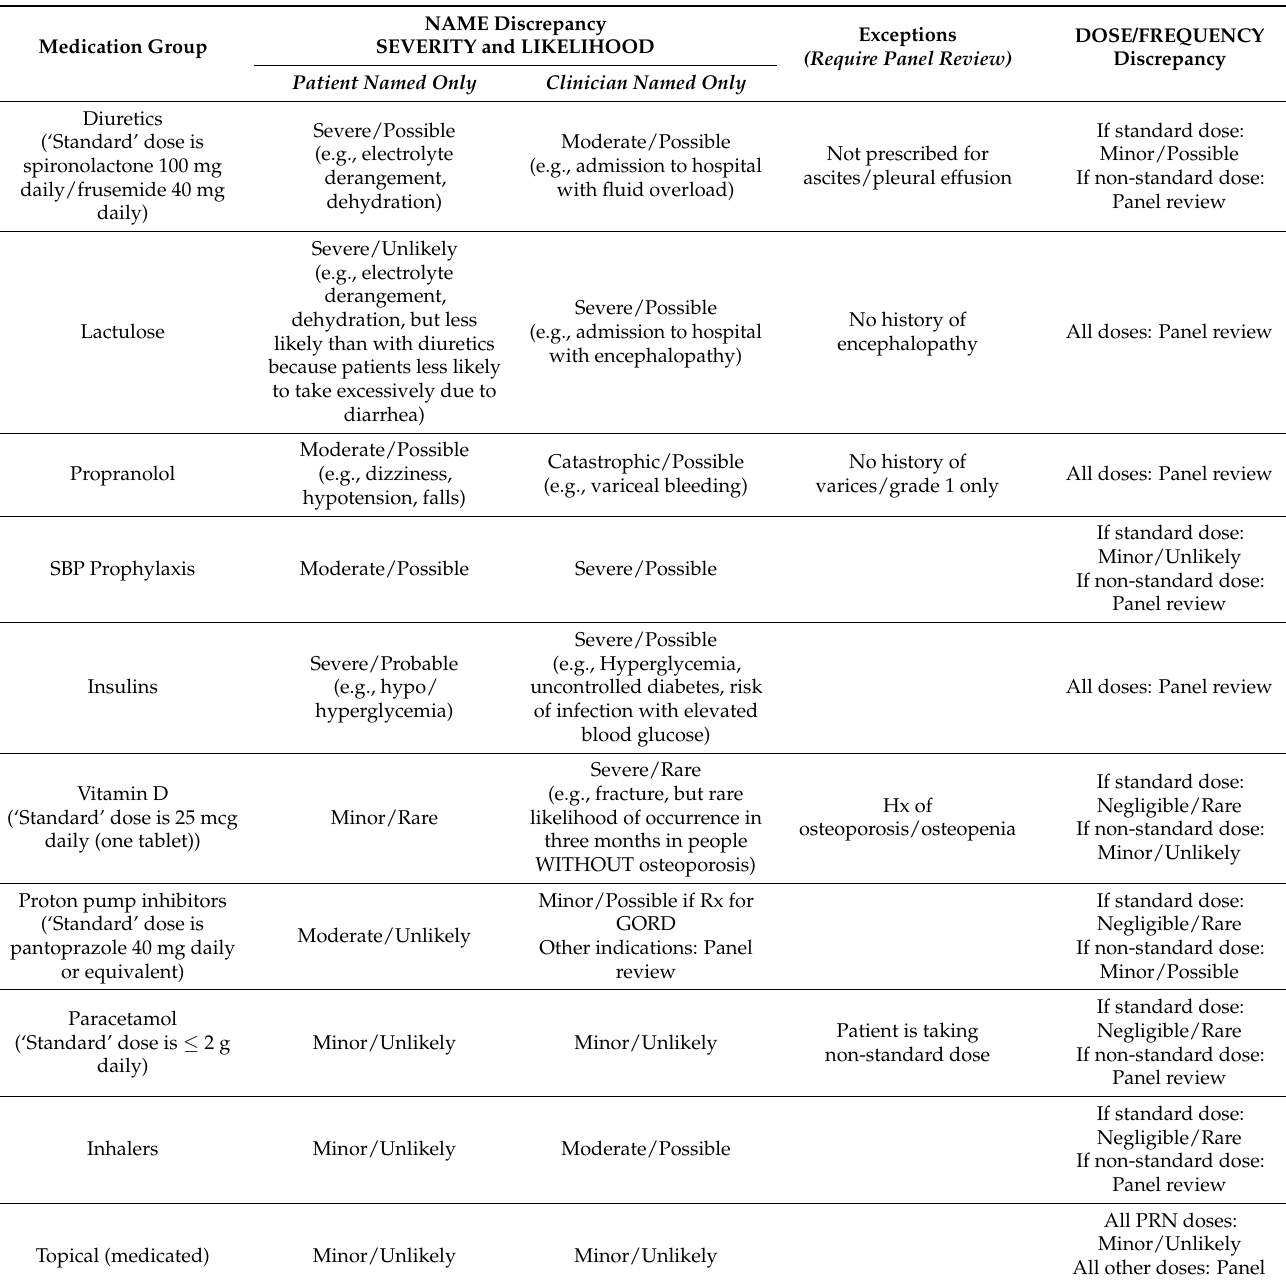
Table A2. Rules and examples of medication discrepancy risk